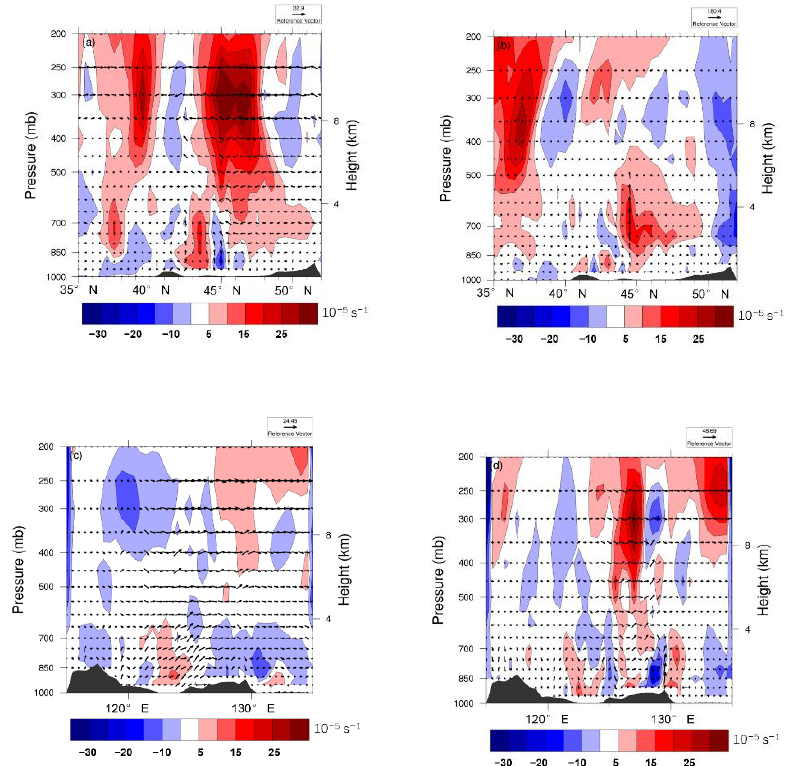
Figure 12. Vertical profile of the resultant wind (Plume): ( a , c ) along longitude 124.0 ◦ E, v at 10:00 LST; ( b , d ) along latitudinal 42.5 ◦ N vorticity (shaded, unit: 10 − 5 s − 1 ), u at 17:00 LST and w* 50 (arrows; m · s − 1 ) in Domain 2 on 3 July